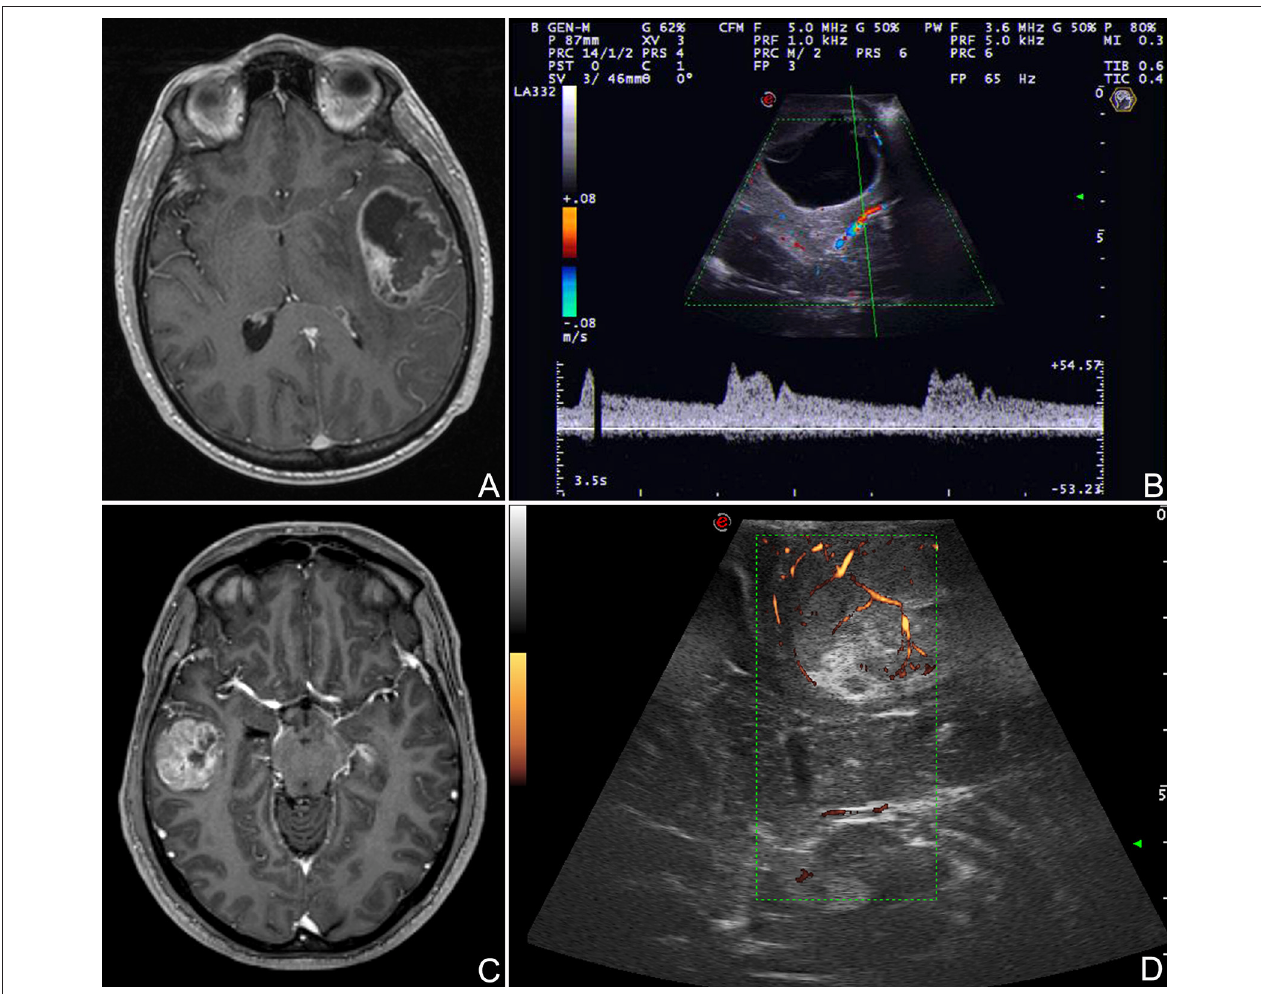
FIGURE 5 | Doppler modalities. (A,B) Color Doppler and spectral doppler in a case of left temporal glioblastoma. (C,D) Power Doppler in a case of right temporal glioblastoma. Color Doppler informs on presence of flow, its direction and velocity through the setting of a region of interest. Spectral Doppler allows for a systematic analysis of flow-velocity over time thus permitting to characterize vessels nature. Power Doppler provides information on amplitude of flow depicting the number of scattering molecules (mainly